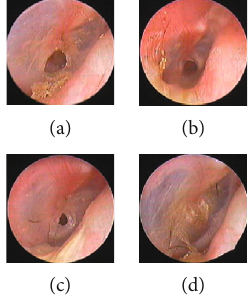
Figure 3: (Patient 8): a 39-year-old man with a right traumatic medium-sized perforation. The 1-week pretreatment perforation (a) and the perforation after 18 months (b) and 3 (c) and 4 (d) weeks of treatment.